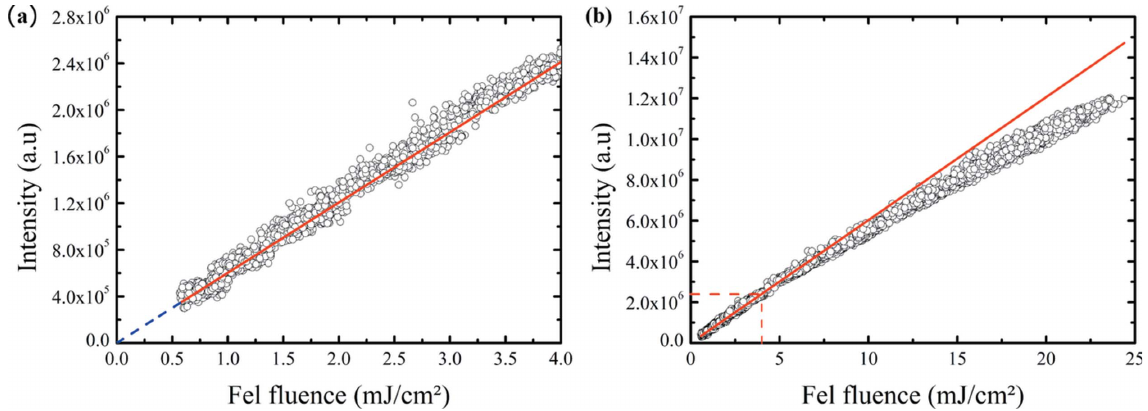
Figure 4 Total signal on the CMOS plotted with respect to the incoming FEL intensity I0 for low fluences ( a ) and for the full range of fluences ( b ). The red curve corresponds to a linear fit of the data points in the low fluence